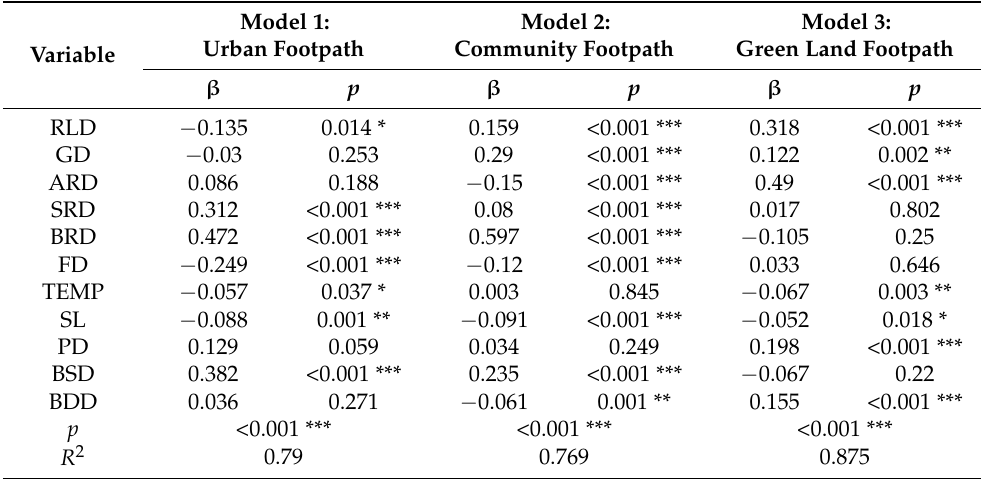
Table 5. Effects of different footpath environments on residents’ JA.